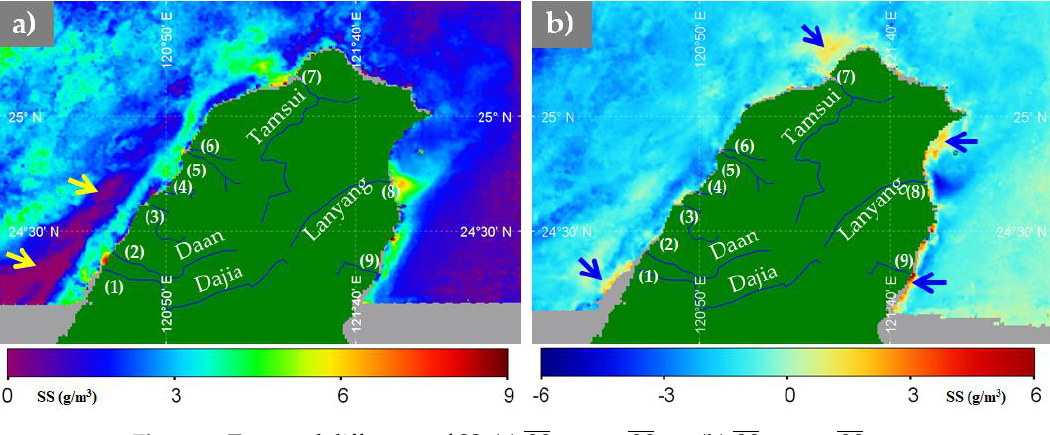
Figure 5. Temporal difference of SS: ( a ) 𝑆𝑆̅̅̅ 11−14 − 𝑆𝑆̅̅̅ 4−7 ; ( b ) 𝑆𝑆̅̅̅ 19−22 − 𝑆𝑆̅̅̅ 11−14 .